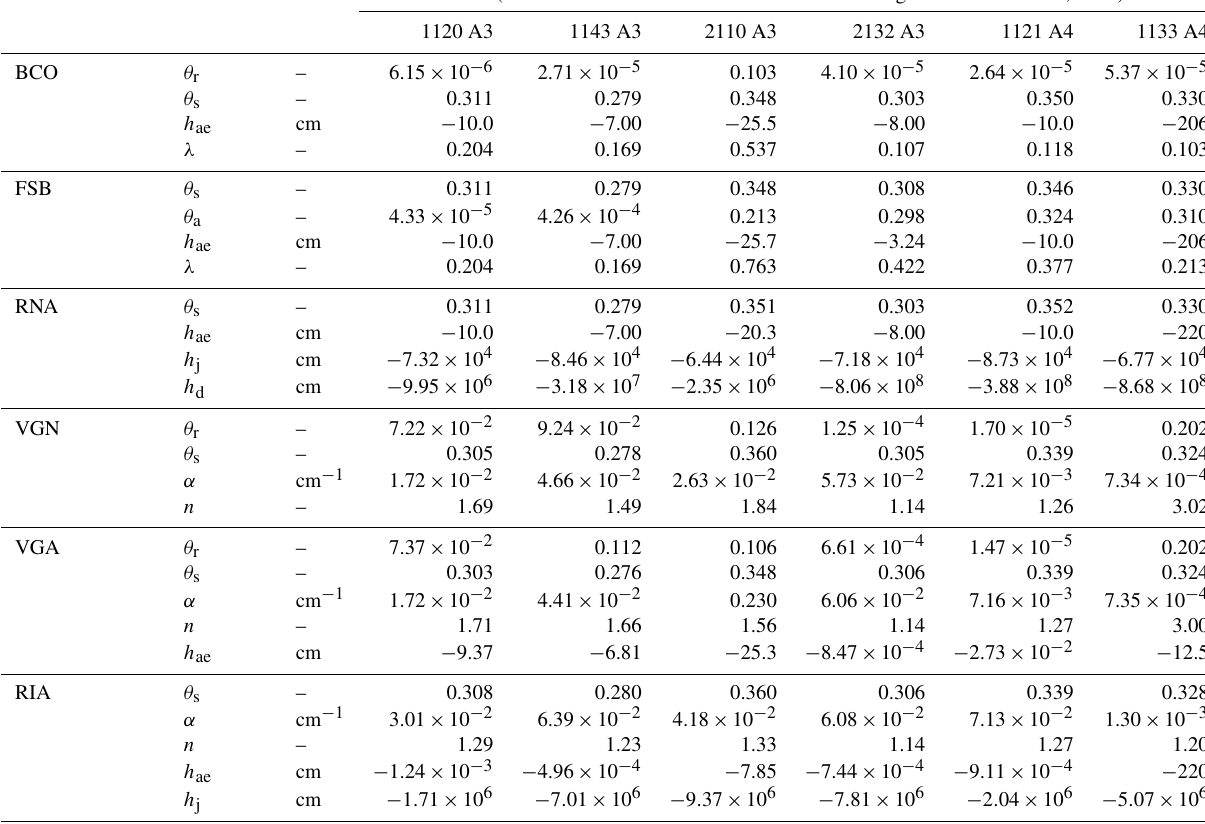
Table C2. The fitting parameters and their values for six parameterizations for sandy soils in the A3 and A4 classifications of Twarakavi et al. (2010) from the UNSODA database (National Agricultural Library, 2015; Nemes et al., 2001). The three-character parameterization label is explained in the main